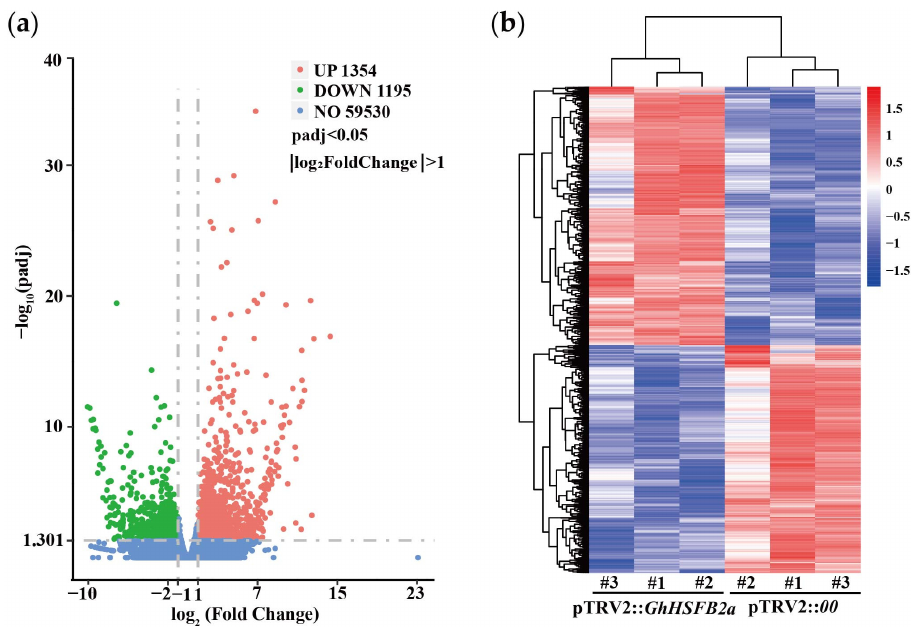
Figure 5. Analysis of DEGs in pTRV2:: 00 and pTRV2:: GhHSFB2a . ( a ) Volcano plot, identification map of DEGs using Log 2 (Fold Change) > 1 and padj < 0.05. ( b ) Heatmap of DEGs of each sample.